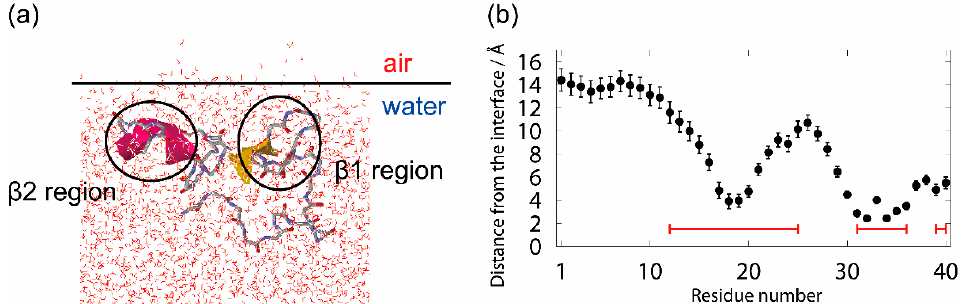
Figure 4. ( a ) A typical snapshot of the A β 40 peptide at the interface. ( b ) The average distance between the C α atoms of each amino acid residue of the A β 40 peptide and the interface. The red lines represent the residues that were bound to the lyso-GM1 micelle in the experiment [122]. Reprinted with permission from Ref. [30]. Copyright 2019 American Chemical Society.